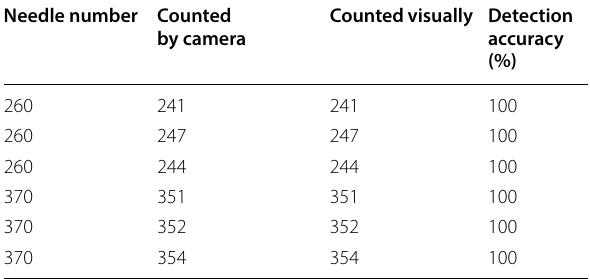
Table 1 Detection accuracy of the inspection system at station 5 for different needle numbers Needle number Counted Counted visually Detection by camera accuracy